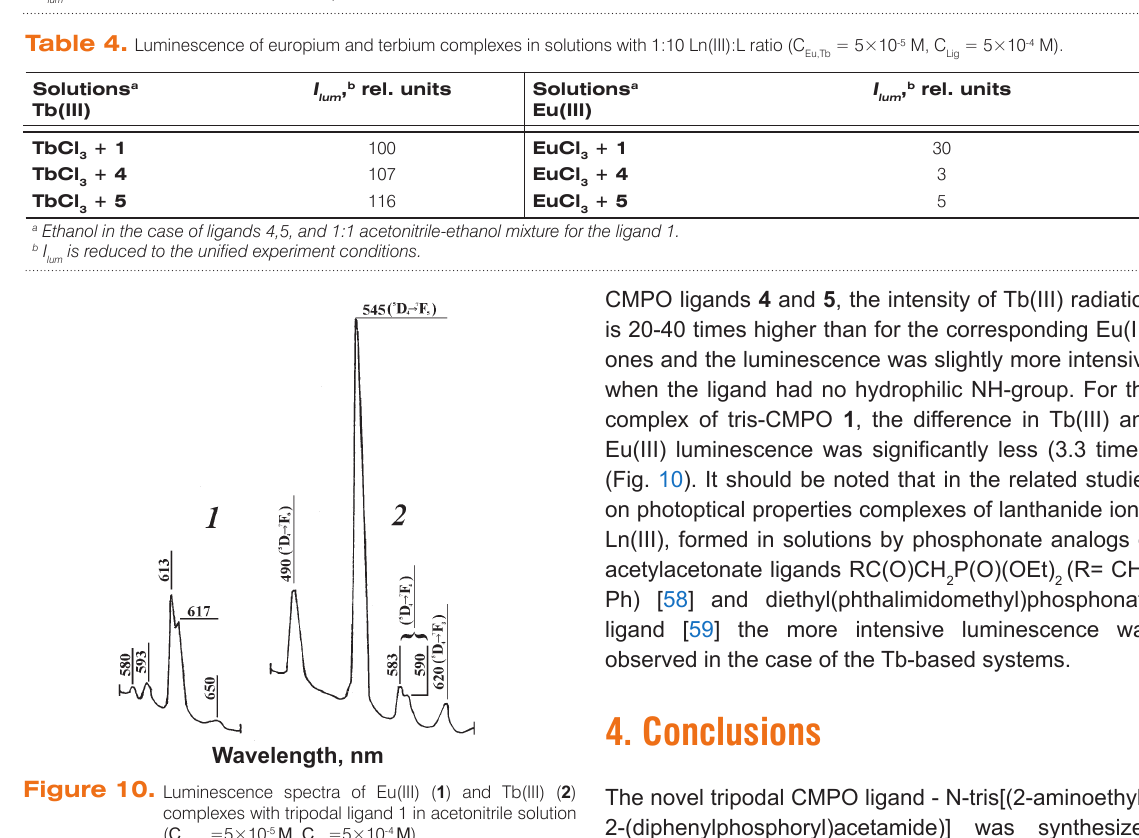
= 5×10 -5 M, C = 5×10 -4 M). Eu,Tb Lig